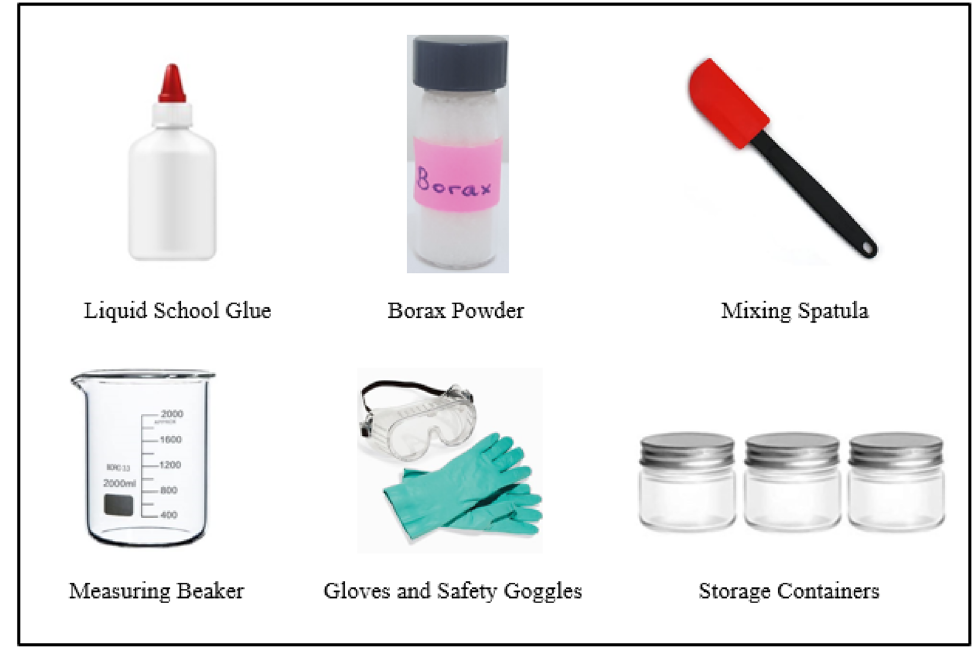
Figure 8. Slime kit for kids: ingredients and